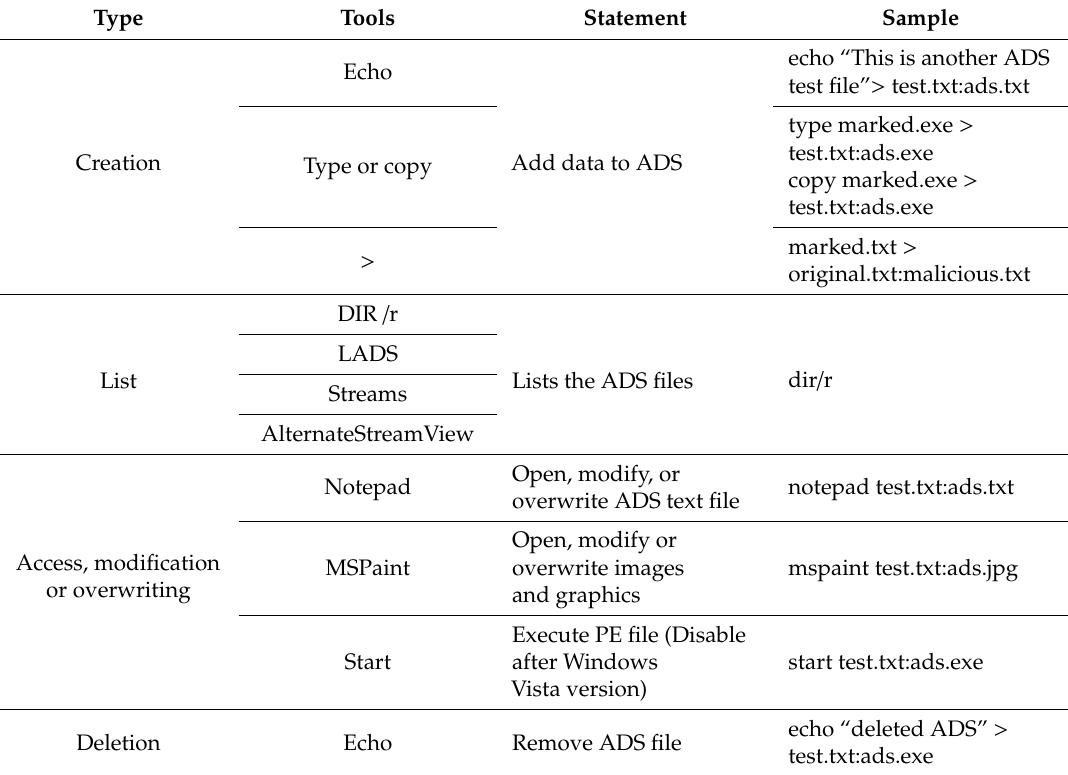
Table 2. Popular ADS (Alternate Data Stream) techniques.